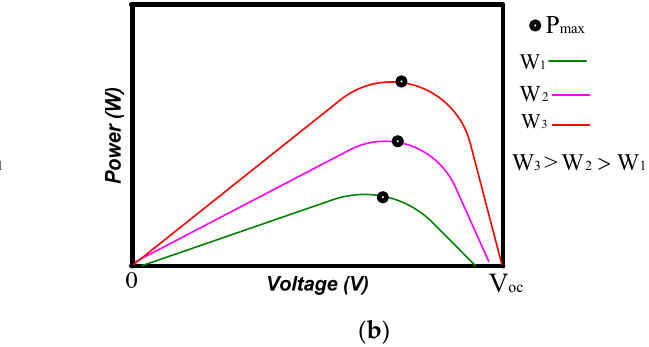
more output power. Figure 5a,b show the effect of irradiance change on PV module (I–V) and (P–V) curves.